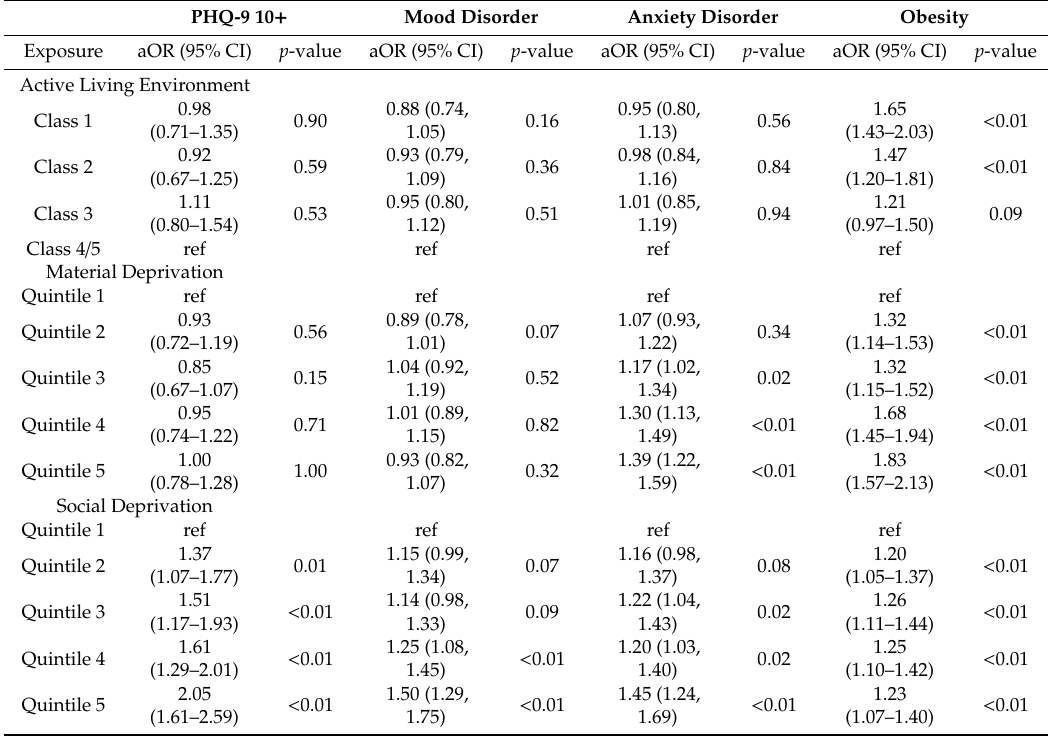
Table 3. Adjusted odds of mental health outcomes and obesity